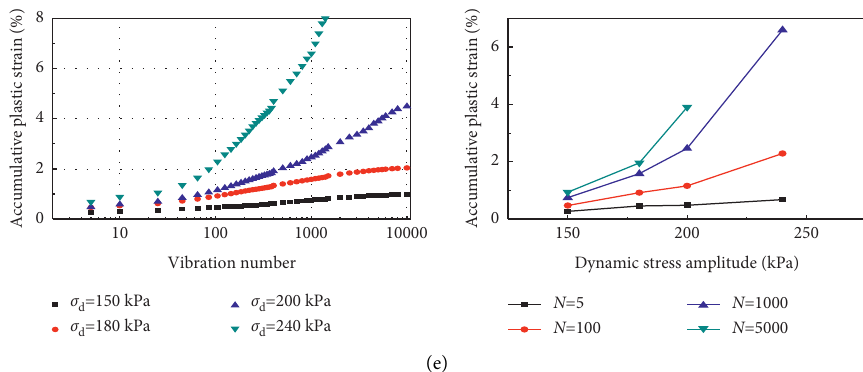
Figure 3: Effect of dynamic stress amplitude on the accumulative plastic strain after different number of freeze-thaw cycles ( N (a) N cyc � 0. (b) N cyc � 1. (c) N cyc � 2. (d) N cyc � 4. (e) N cyc �